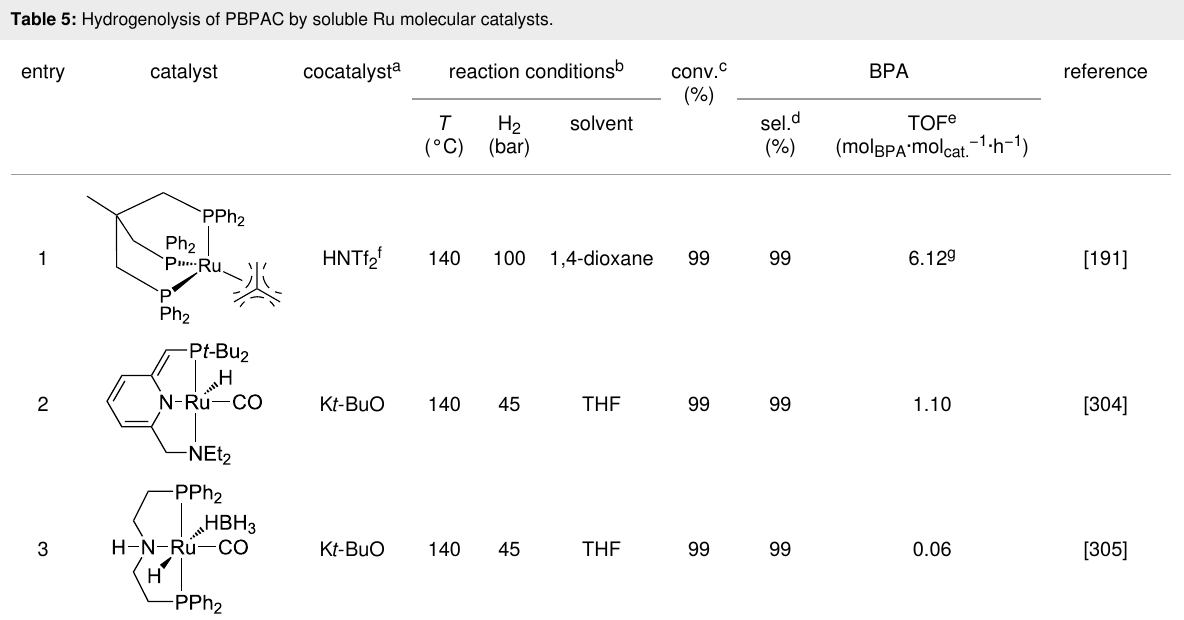
Table 5: Hydrogenolysis of PBPAC by soluble Ru molecular catalysts.